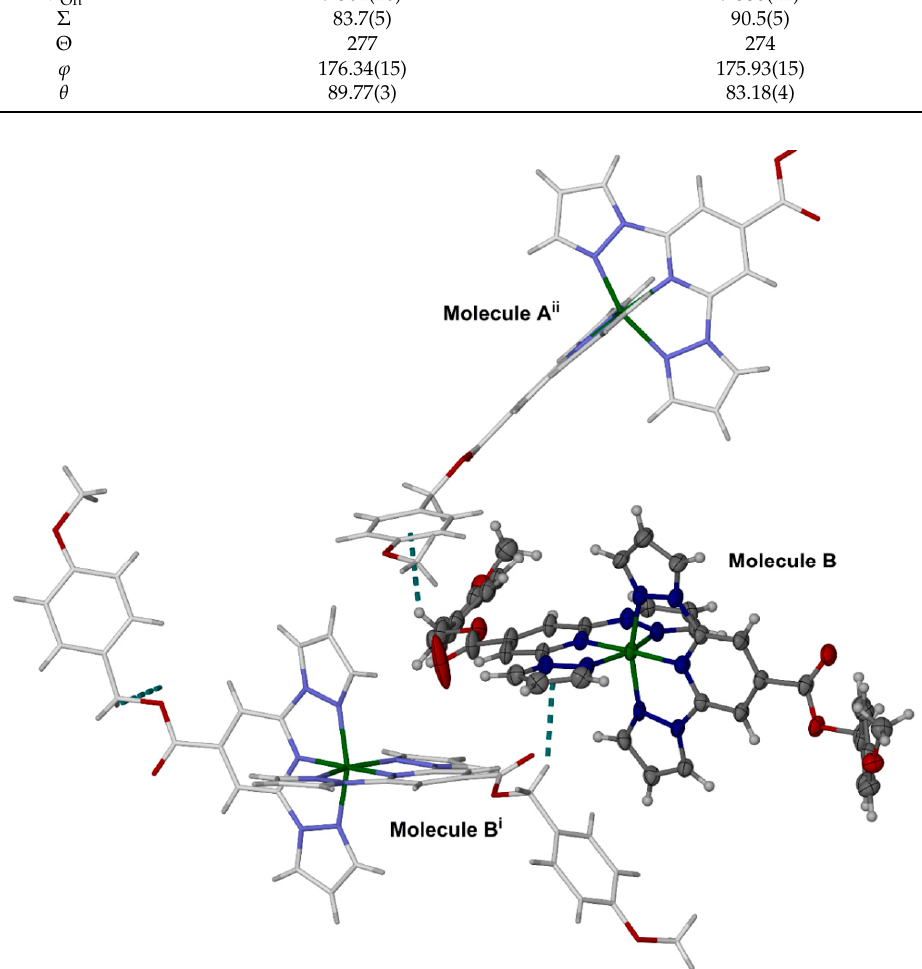
Figure 2. Intermolecular C-H . . . π interactions causing the twisted ligand conformation in molecule ‘B’ of [Fe( L 6 ) 2 ][BF 4 ] 2 · 3 / 2 MeCN, which is highlighted with dark colouration. Symmetry codes: (i) x , 3 / − y , 1 + z ; (ii) 1 − x , 1 − y , 1 − z . Colour code: C, white or dark grey; H, pale grey; Fe, green; N, 2 2 pale or dark blue; O,